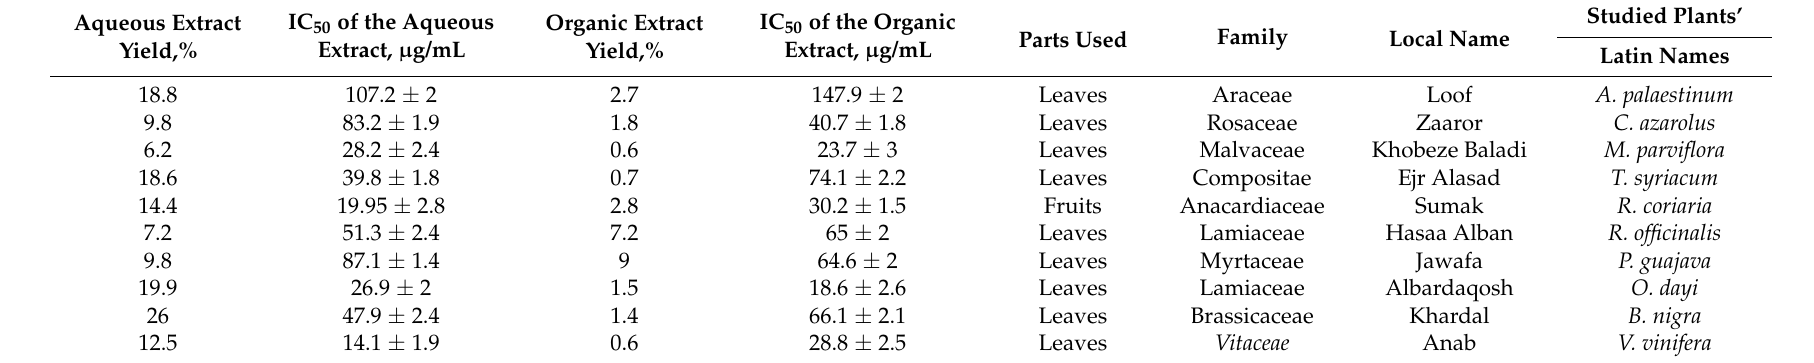
Table 1. Porcine pancreatic lipase inhibitory properties, expressed as IC 50 ( µ g/mL), and yield percentages of the aqueous and organic extracts of 10 plant species that were collected from different regions in